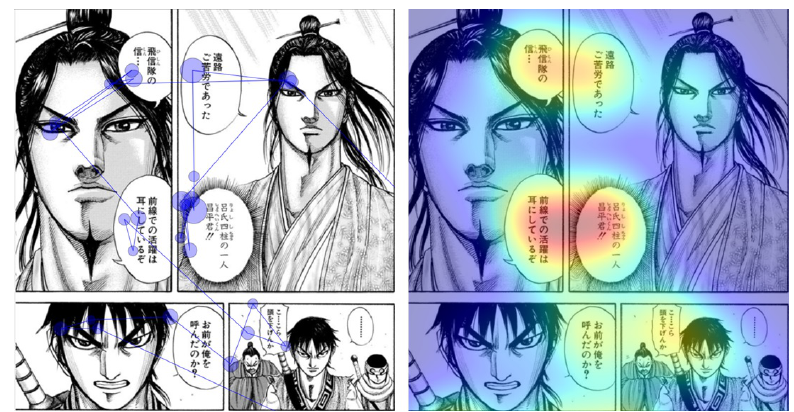
Figure 10. ( left ) Eye gaze fixations (blue circles) and saccades (segment between circles) of one reader; and ( right ) heat map accumulated over several readers, where red corresponds to longer fixation